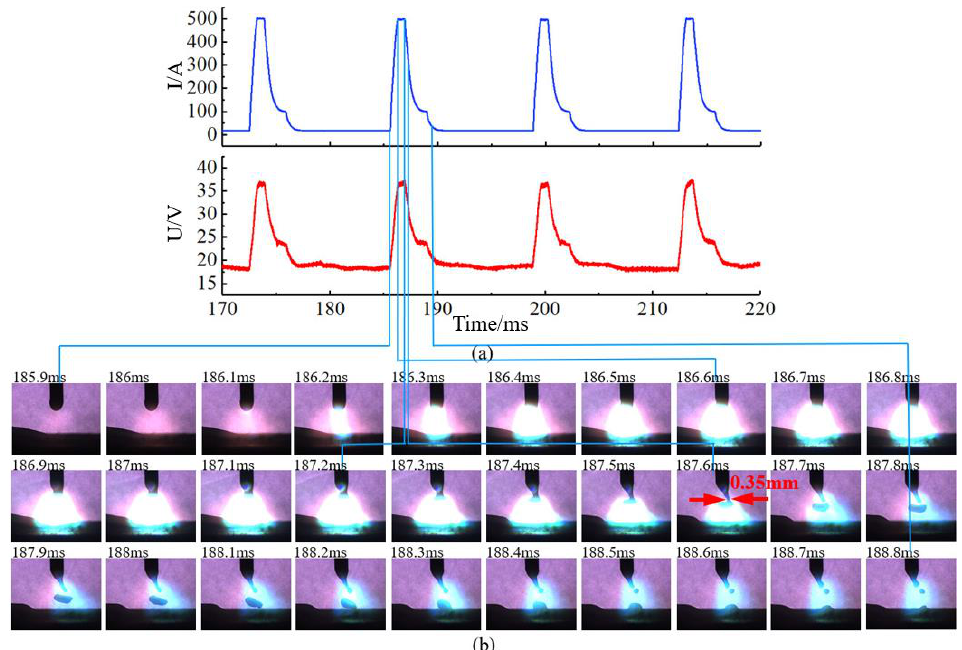
Figure 12. P-GMAW electronic signal and arc and droplet transition behavior photographs (trapezoid pulse waveforms, I = 100 A): ( a ) current and voltage signal; ( b ) synchronous photographs.